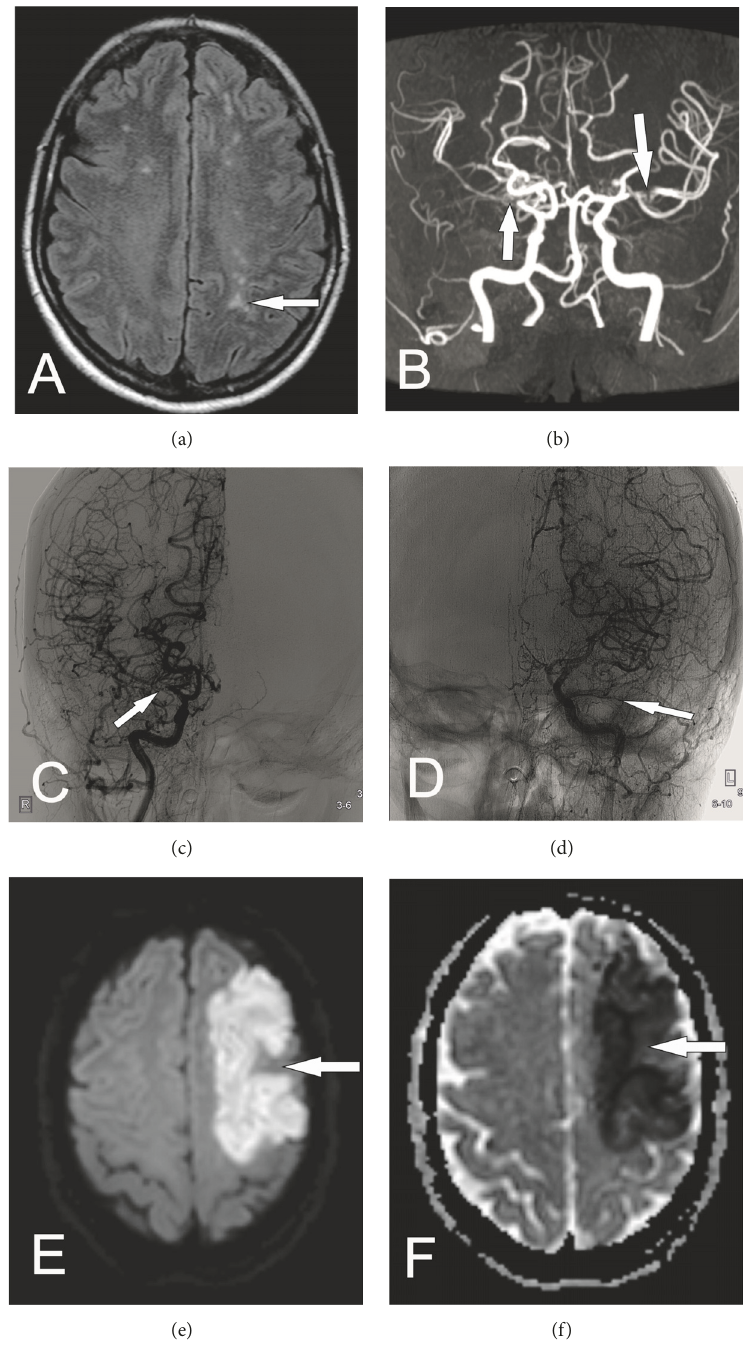
Figure 1: (a) Axial FLAIR image reveals multiple hyperintensities in watershed territories. (b) Time of Flight MRA shows bilateral MCA occlusions (arrows). (c, d) DSA of the right (c) and left (d) internal carotid arteries verifies the MCA occlusions (white arrows). Proliferation of small abnormal net-like vessels is also noticed. Diffusion Weighted Imaging (e) and Apparent Diffusion Coefficient (ADC) map (f) reveal diffusion restriction in the left MCA territory due to an acute infarct